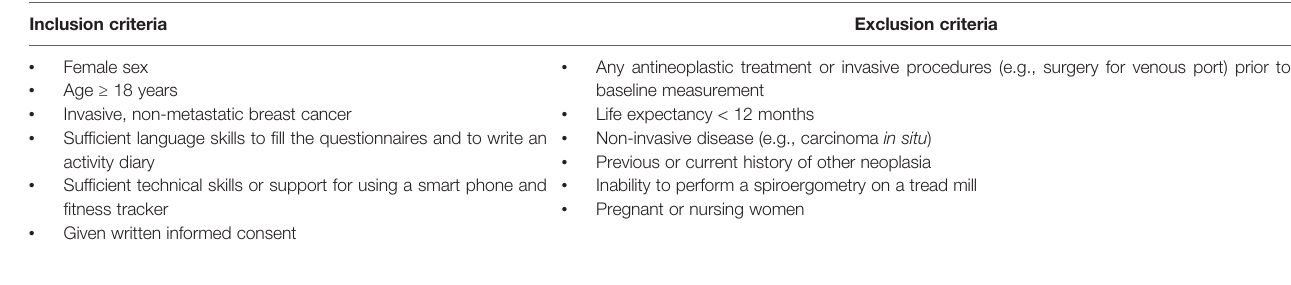
TABLE 1 | Inclusion criteria and exclusion criteria of the BEGYN study. Inclusion